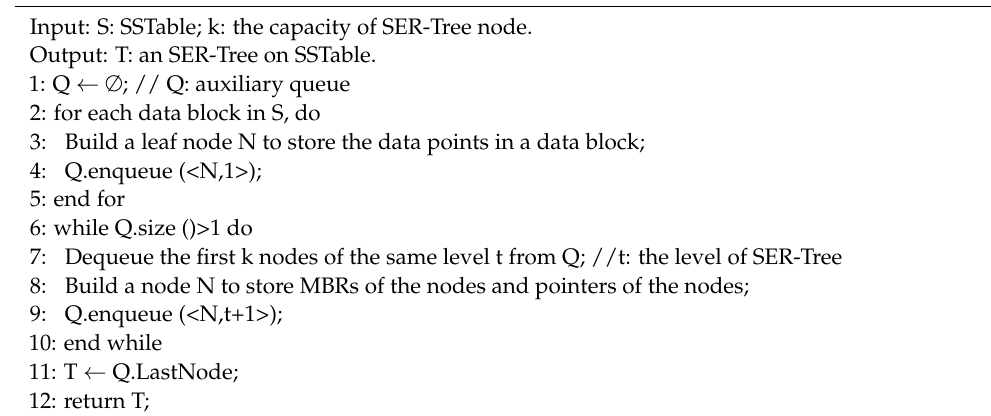
Algorithm 1 SER-tree build algorithm